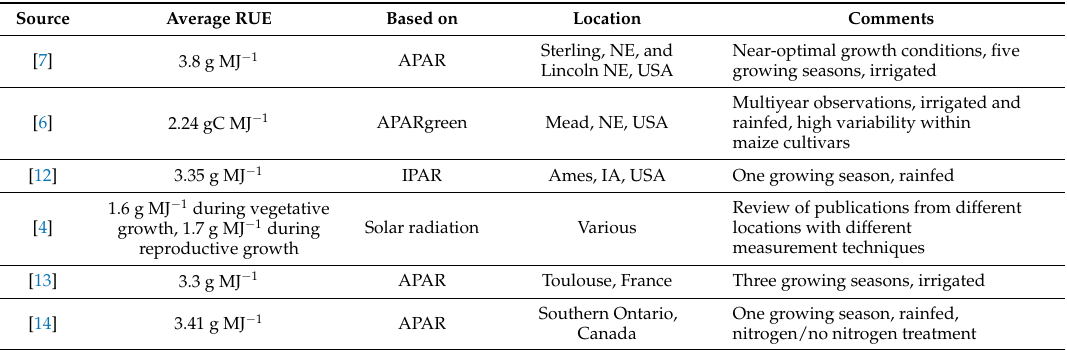
Table 1. List of maximum radiation use efficiency (RUE) values reported for